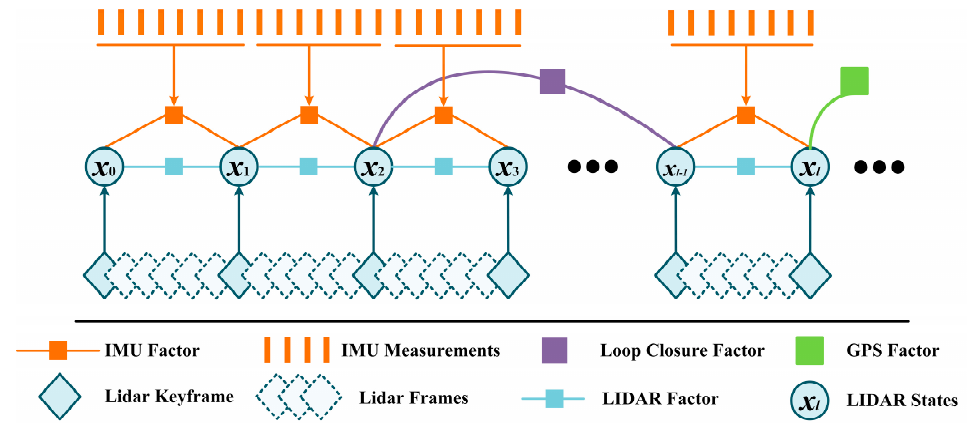
Figure 6. Factor graph structure of LIO-SAM.